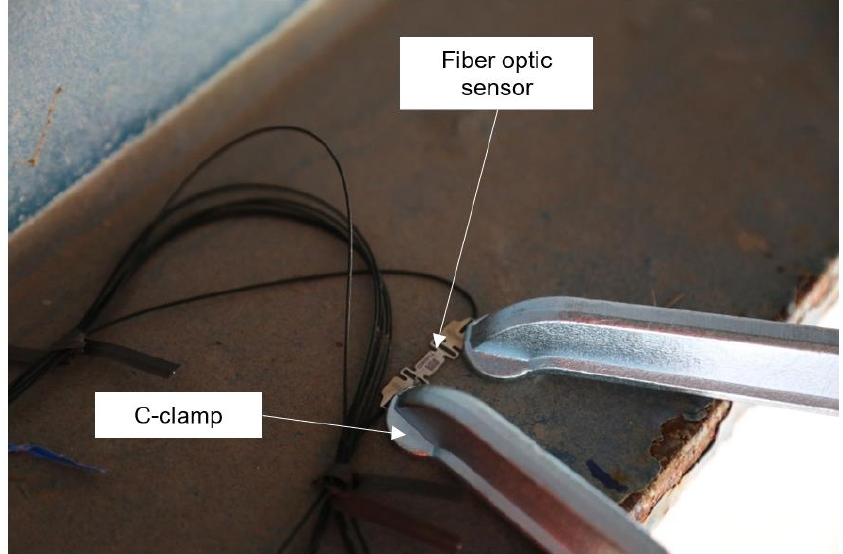
Figure 10. Fiber optic sensor mounted to bottom flange using C-clamps.